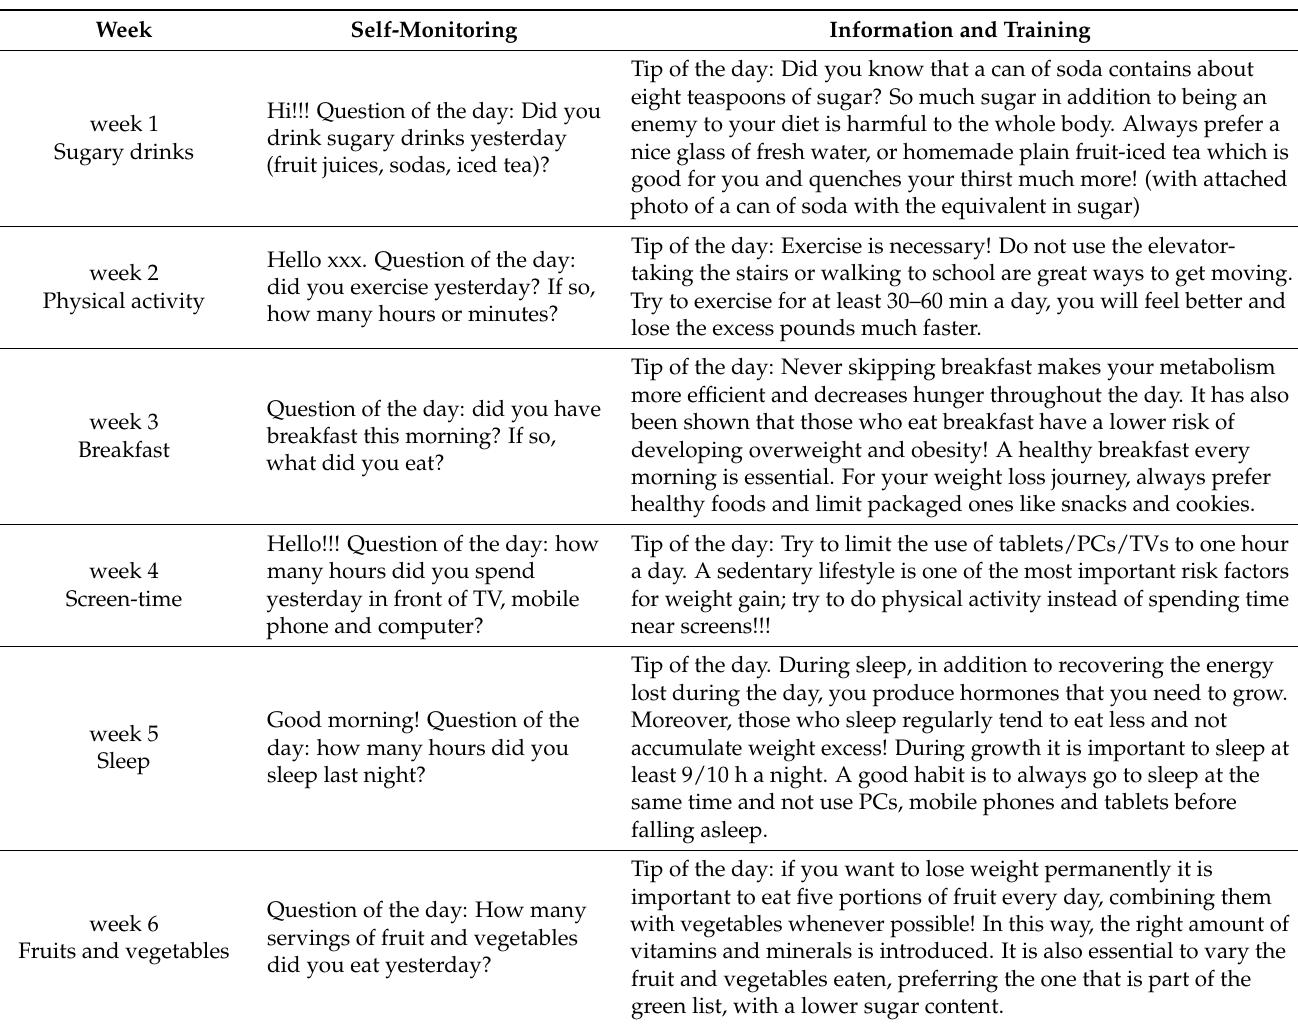
Table A1. Scheme of “self-monitoring messaging” (English version).